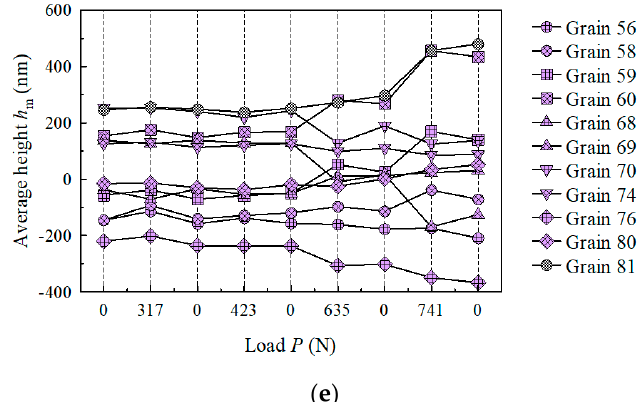
Figure 5. Change in height distribution with load P at each load step. ( a ) Grains 1 to 12; ( b ) grains 13 to 23; ( c ) grains 25 to 41; ( d ) grains 42 to 55; and ( e ) grains 56 to 81.